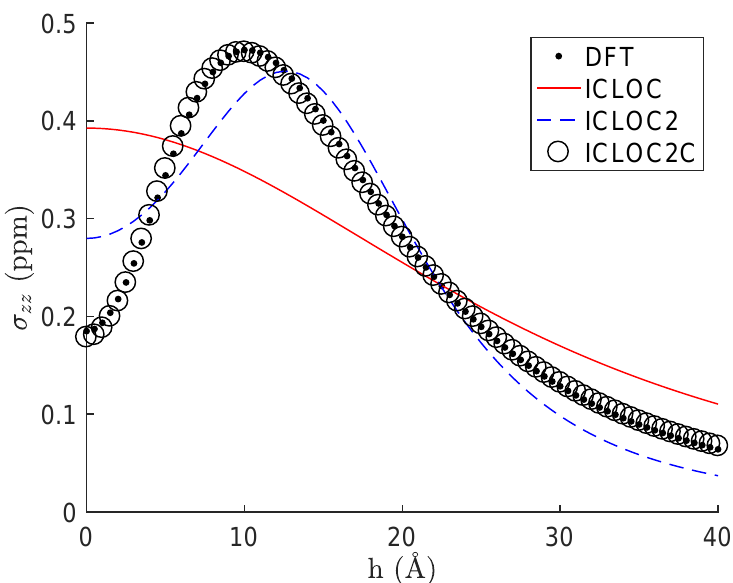
Figure 1. Magnetic shielding component σ zz computed at the BHandHLYP/6-31G* level (small dots) and its nonlinear fit according to three RCMs: ICLOC, ICLOC2, and